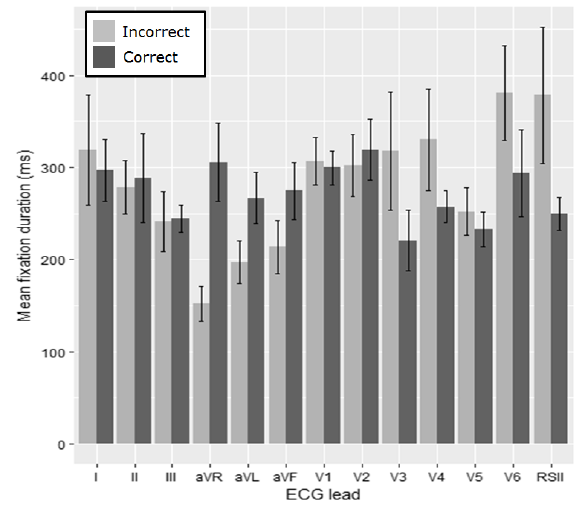
Figure 7. Average fixation duration for both groups, per lead (errorbars represent the SE)